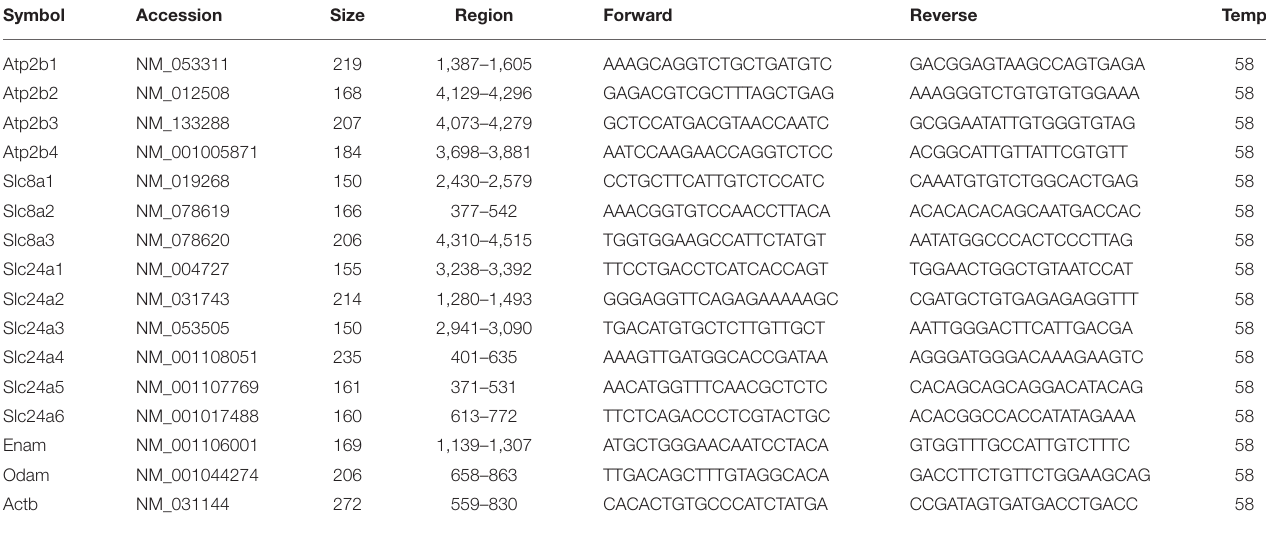
TABLE 2 | Primers used for real-time